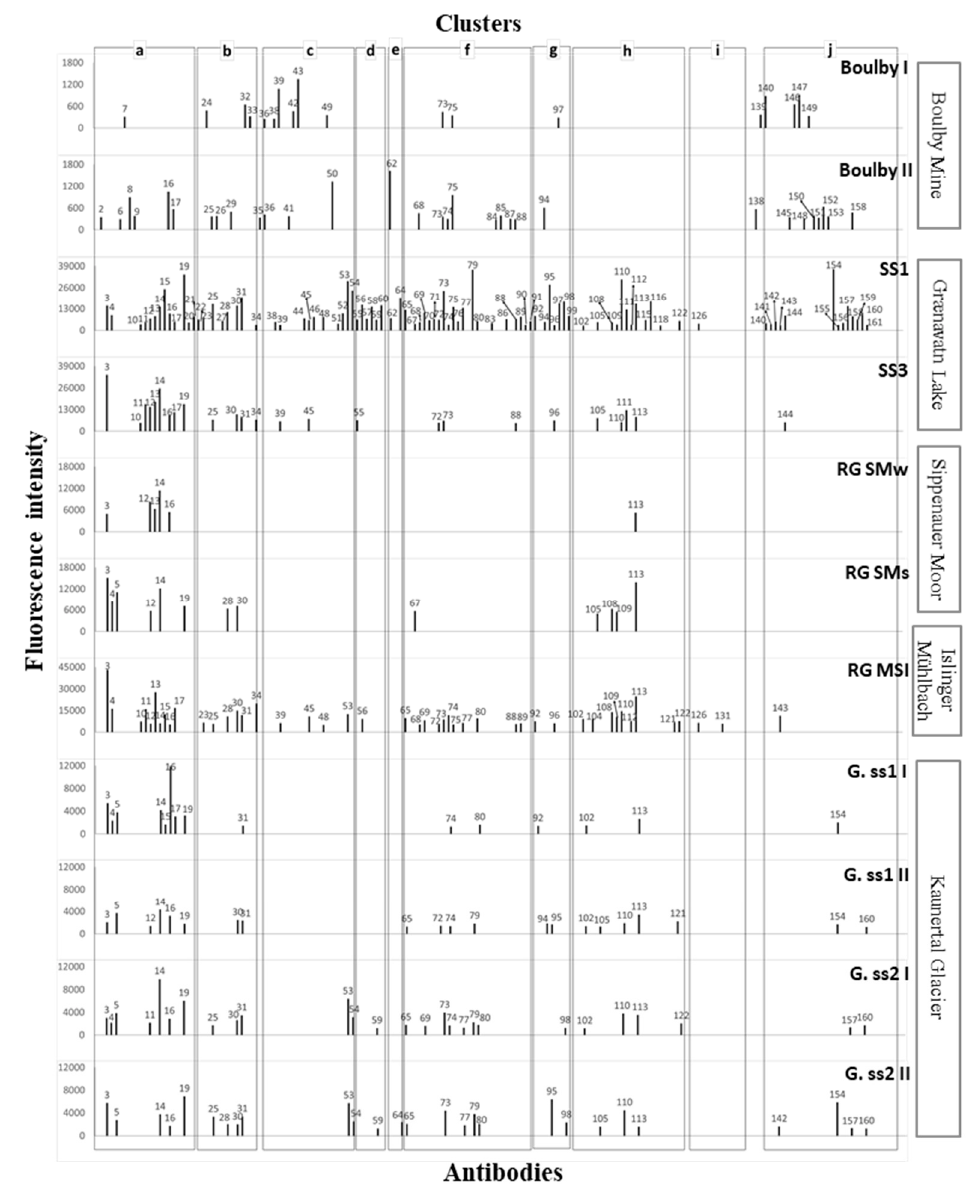
Figure 2. Immunograms of water and sediment samples of each Mars Analogues for Space Exploration (MASE) site (explained in Material and Methods section). Plots show the positive immunodetections and their fluorescence intensity. The peak numbers correspond to the antibody detected in each reaction and are listed in Table S1. Letters above from a to j frame those antibodies of positive immunodetections that has been clustered as follows: a . Fe–S oxidizers cultures; b . metal-acidic environment (water source); c . psycrophilic cultures; d . iron reducers; e . spores; f . mesophilic cultures; g . archaea; h . cyanobacteria; i . perchlorate reducers; and j . proteins and peptides. Moreover, some groups are represented by a sole antibody: Peaks 35, Ab ID: IIC1C1 geothermal environment; 138, Ab ID: VIID1BF, mesophilic environment; and 139, Ab ID: VD2BF, biofilm from mines. Please note that scales of the Y axes (fluorescence intensity) are not the same for every site, but they remain homogenous within each one.